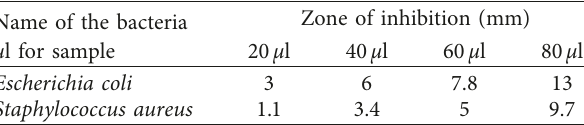
Table 3: Antibacterial activity